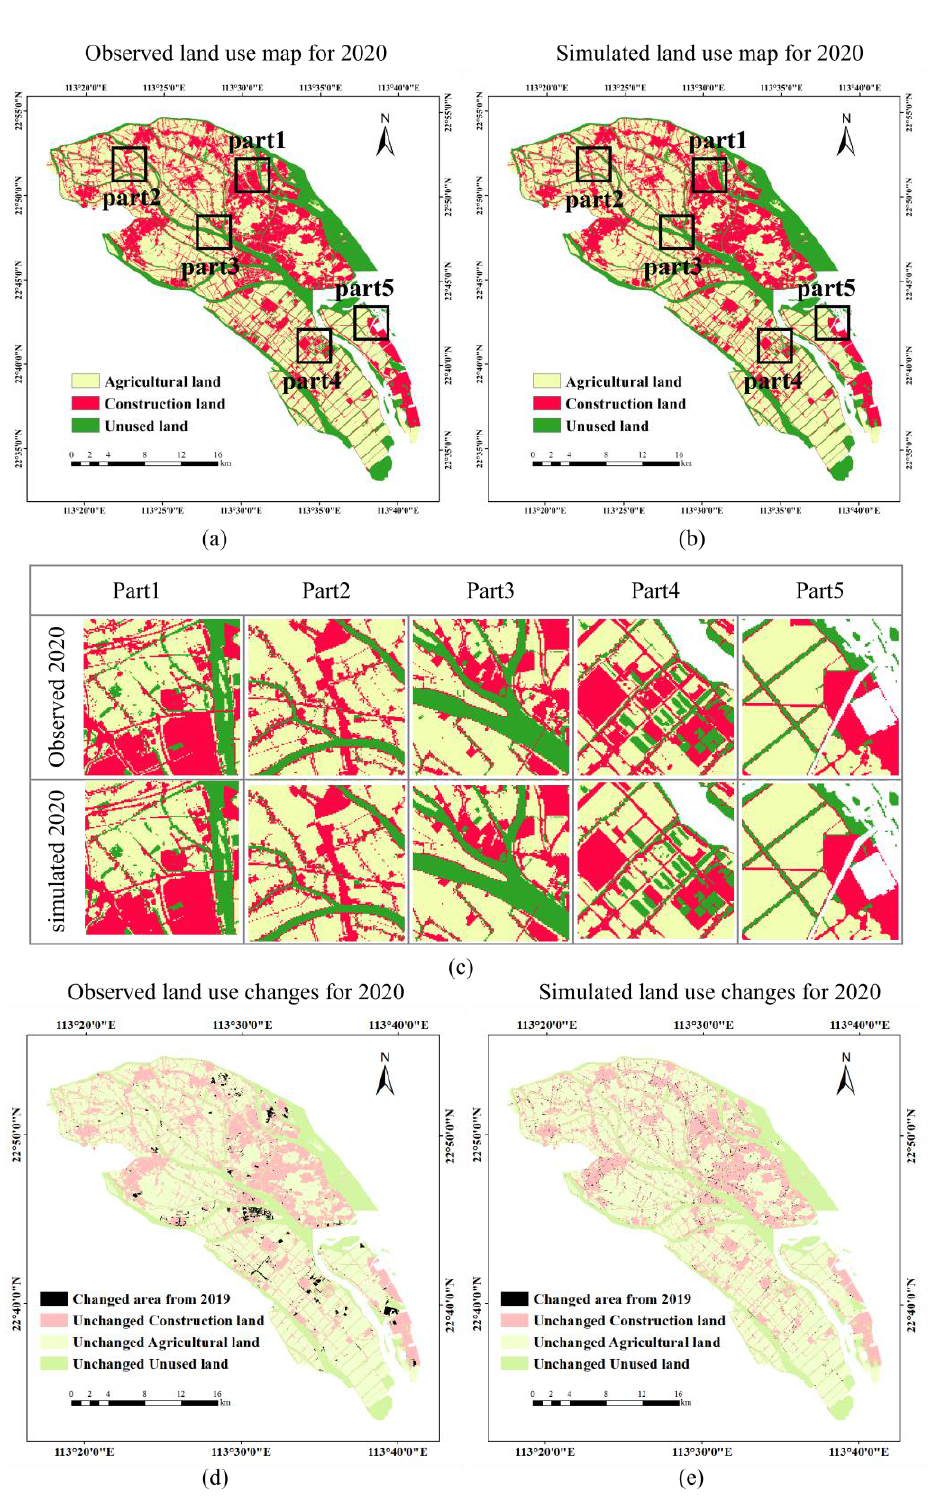
Figure 6. Comparison of observed land use map and simulated map for 2020: ( a ) Observed land use map for 2020; ( b ) Simulated land use map for 2020; ( c ) Comparison of observed map and simulated map from part1 to part5; ( d ) Observed land use changes for 2020; ( e ) Simulated land use changes for 2020.